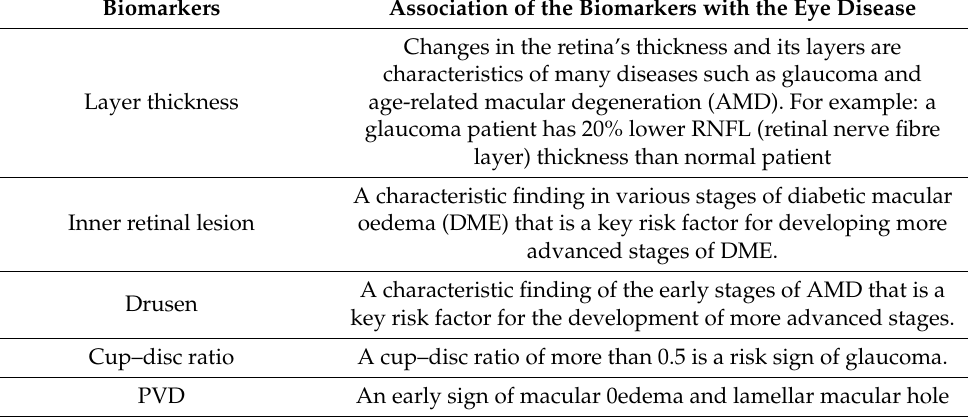
Table 1. Biomarker associated to eye disease. Biomarkers Association of the Biomarkers with the Eye Disease Changes in the retina’s thickness and its layers are characteristics of many diseases such as glaucoma and Layer thickness age-related macular degeneration (AMD). For example: a